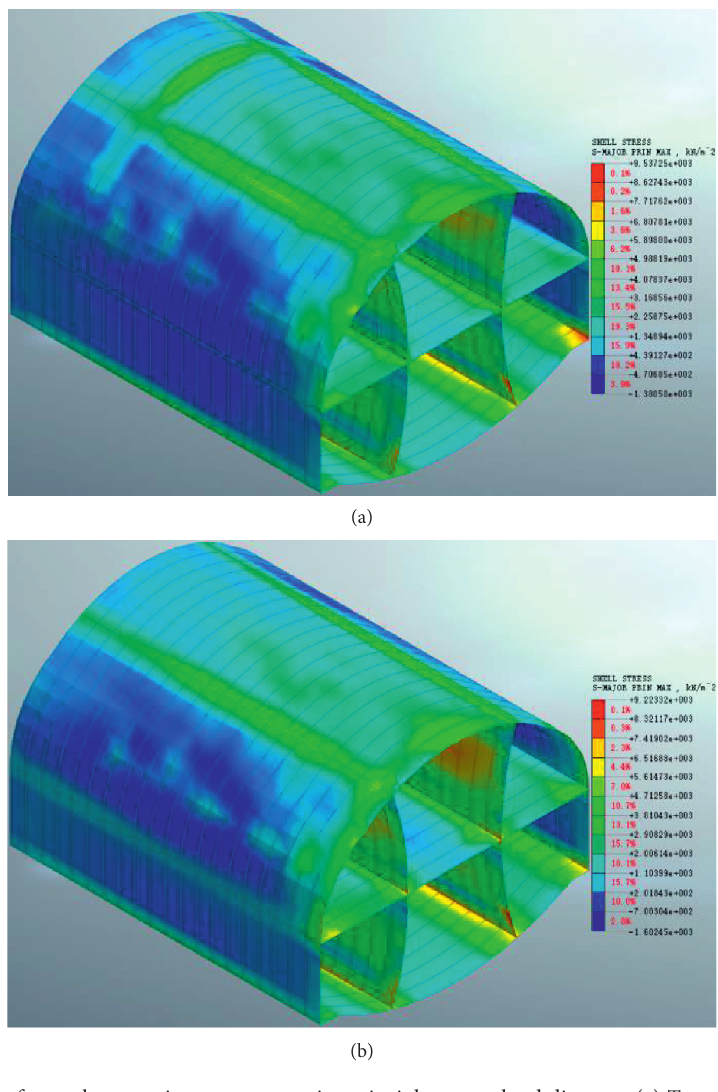
Figure 8: Different schemes of tunnel supporting structure major principle stress cloud diagram. (a) Tunnel supporting structure major